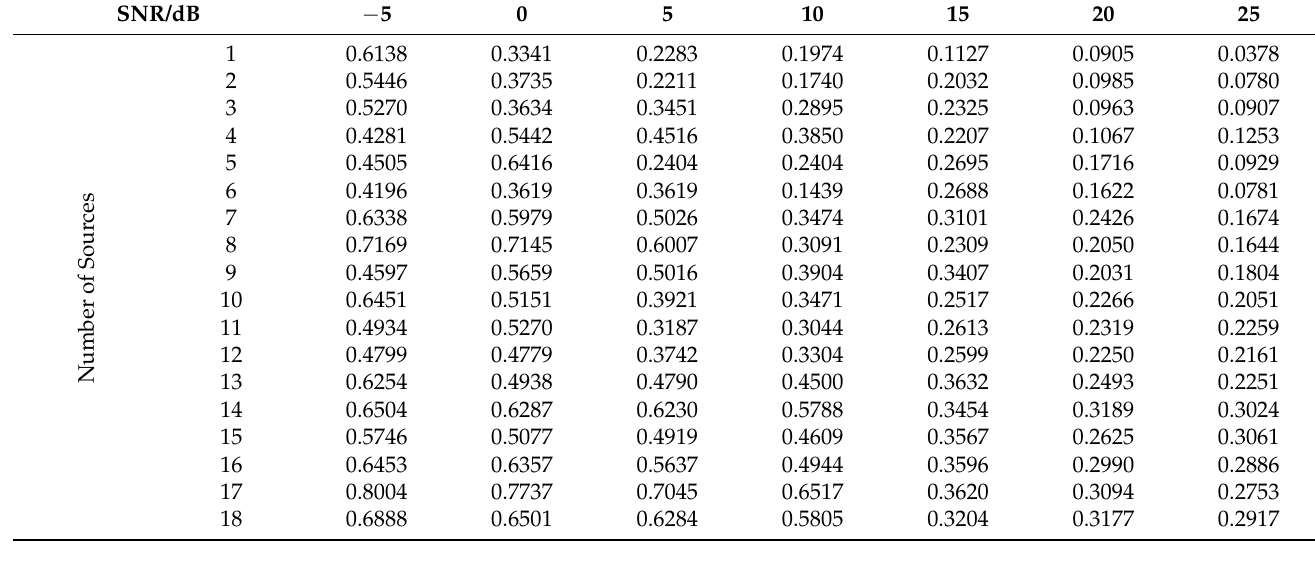
Table 7. RMSE of DOA estimation for sparse array at different SNRs.